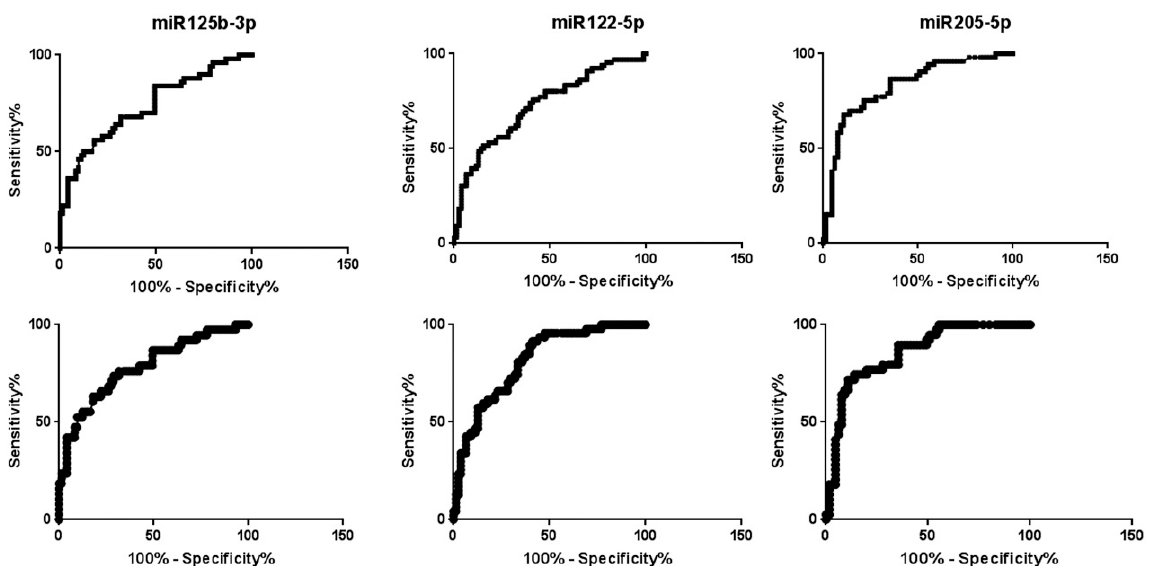
Figure 3. The upper graphics represent ROC curves of miR125b-3p, 122-5p, and 205-5p for overall pancreatic cancer and healthy controls, with AUC values of 0.736, 0.726, and 0.829, respectively. The lower graphics represent ROC curves of miR125b-3p, 122-5p, and 205-5p only for adenocarcinoma pancreatic cancer and healthy controls with AUC values of 0.782, 0.814, and 0.857. An in-silico analysis using DIANA-miRPathv3.0 using Tarbase as a reference to ac- cess KEGG pathways related to the three significantly overexpressed miRNA returned significant results for several pathways, including pancreatic cancer (KEGG pathway